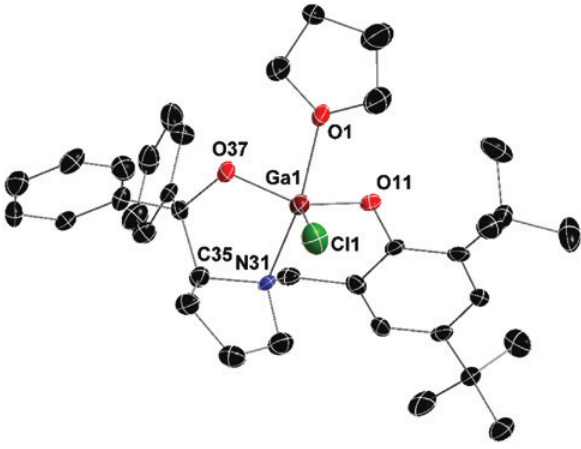
Figure 9: ORTEP representation of the molecular solid-state structure of ( S )-{OˆO}GaCl·THF ( 4·THF ). Ellipsoids drawn at the 50% probability level. H atoms omitted for clarity. Selected bond lengths (Å) and angles ( ° ): Ga1-O11 = 1.830(4), Ga1-O37 = 1.836(4), Ga1-O1 = 2.107(4), Ga1-N31 = 2.113(5), Ga1-Cl1 = 2.206(2); O11-Ga1- O37 = 127.9(2), O11-Ga1-O1 = 85.69(17), O37-Ga1-O1 = 83.97(17), O11-Ga1-N31 = 94.59(18), O37-Ga1-N31 = 84.35(18), O1-Ga1- N31 = 165.37(19), O11-Ga1-Cl1 = 111.02(15), O37-Ga1-Cl1 = 120.26(15), O1-Ga1-Cl1 = 91.97(15), N31-Ga1-Cl1 =